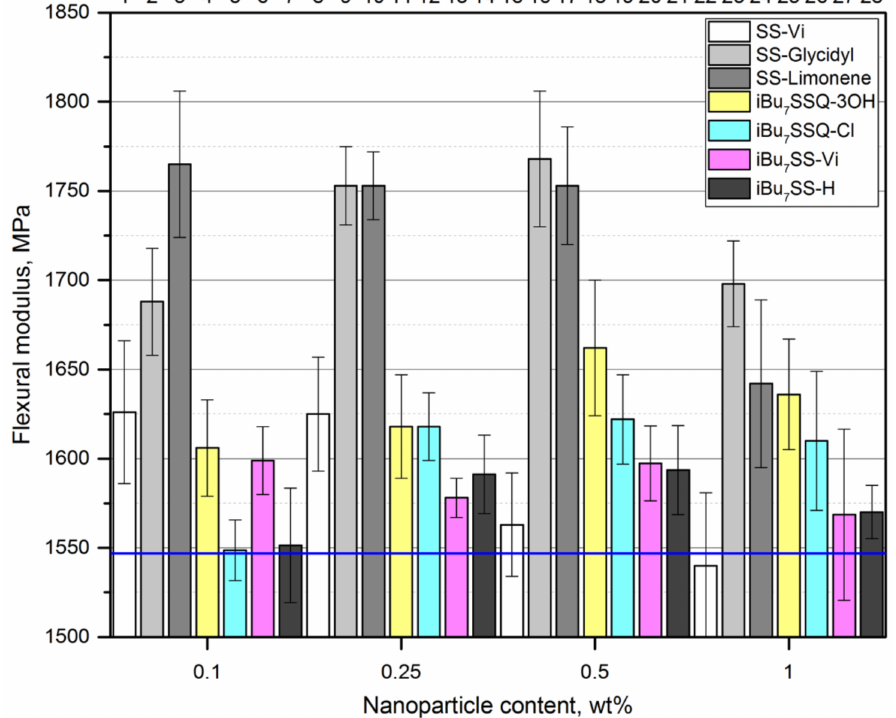
Figure 9. Flexural modulus of the CS/iPP